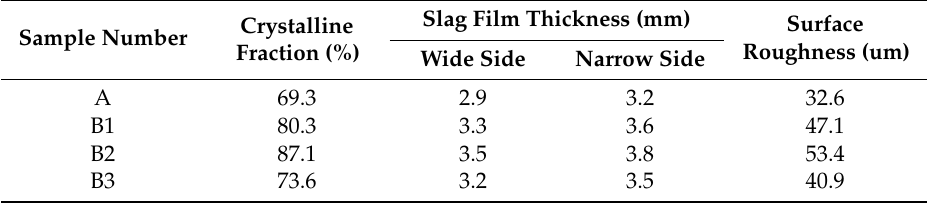
Table 2. Crystalline fraction, slag film thickness, and surface roughness of slag films.